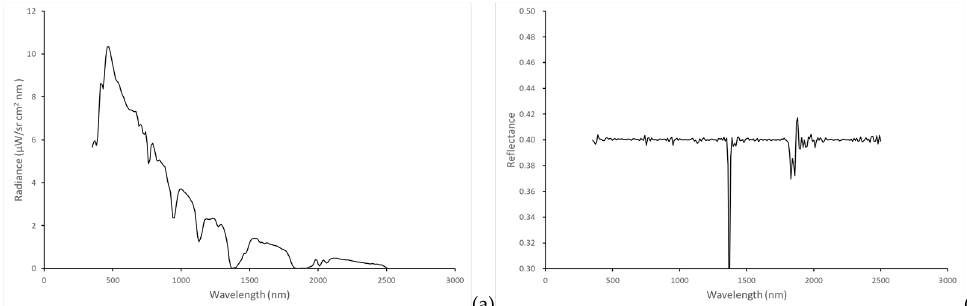
Figure 4. At sensor radiance simulated by MODTRAN corresponding to an albedo of 0.4 ( a ) and related atmospherically corrected spectrum ( b ).